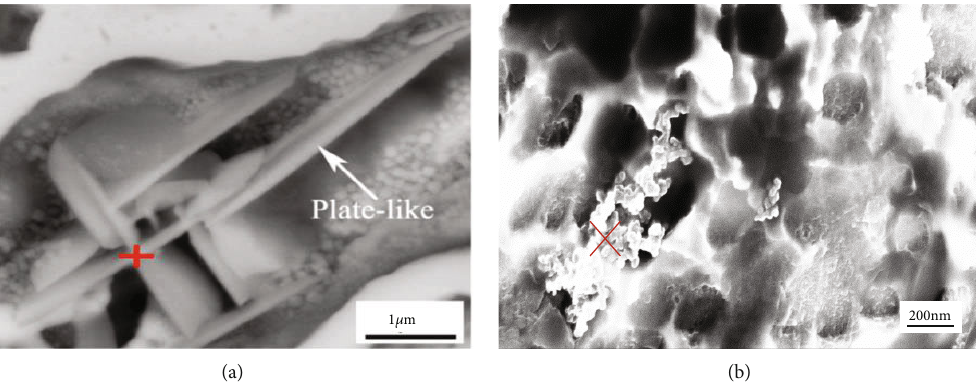
Figure 6: The magni fi ed microstructures of GH4720Li alloy corresponding to the closed rectangle area in Figure 7(a) [12] and Figure